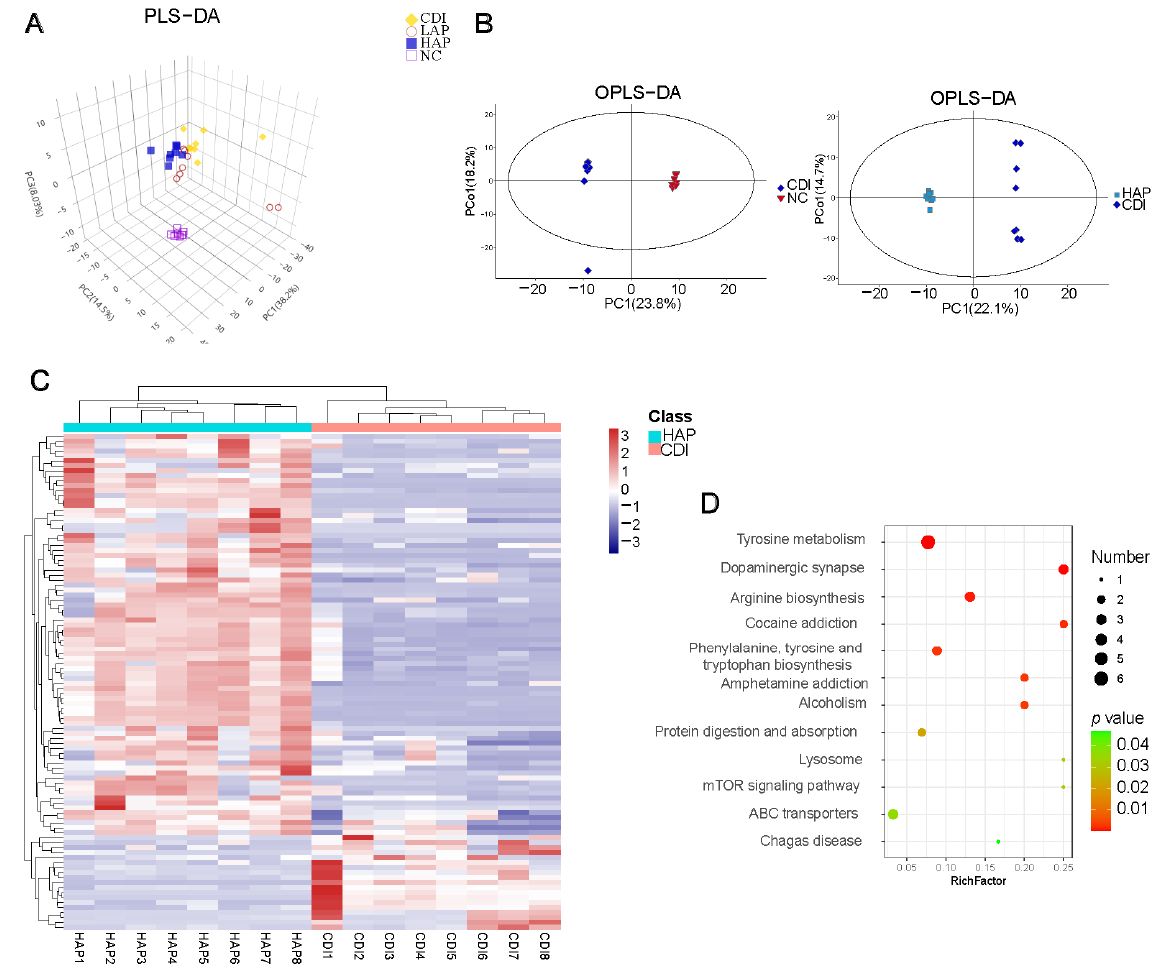
Figure 5. APE attenuated C. difficile-induced metabolic disorders. ( A ) PLS-DA shows metabolic structures of different groups. ( B ) OPLS-DA plot comparing groups. ( C ) Heatmap of differential metabolites between HAP and CDI groups. ( D ) KEGG pathway enrichment map. Circle size shows the number of enriched metabolites, and color scale represents p value.